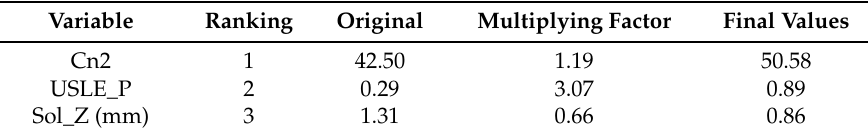
Table 3. Calibration parameters.